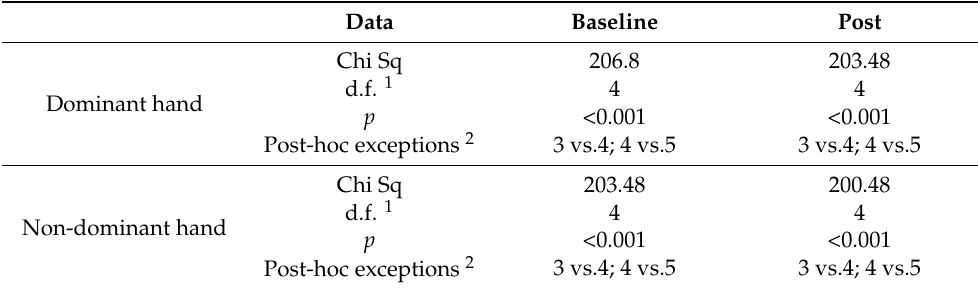
R = 0.95, p < 0.001 Table 14. Kruskal-Wallis test followed by the Dunn-Bonferroni post-hoc between BBT scores and